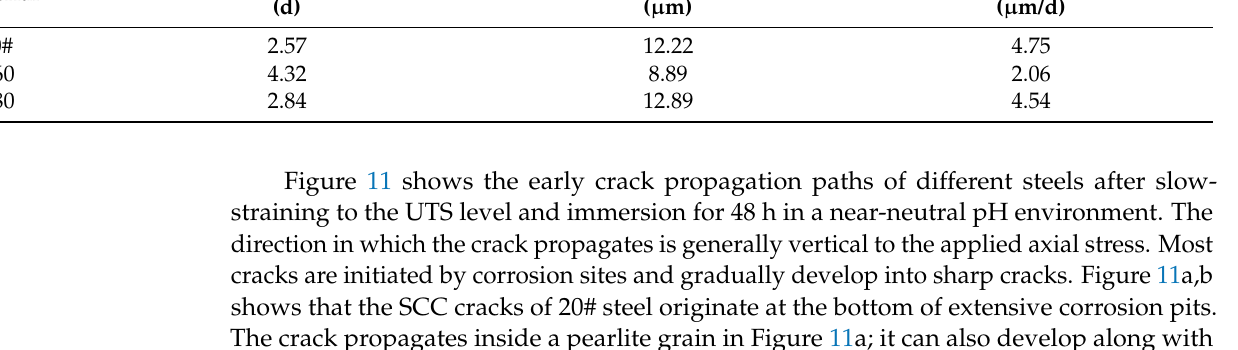
Table 4. The average SCC growth rate of the deepest crack in the 20#, X60, and X80 steels. Material